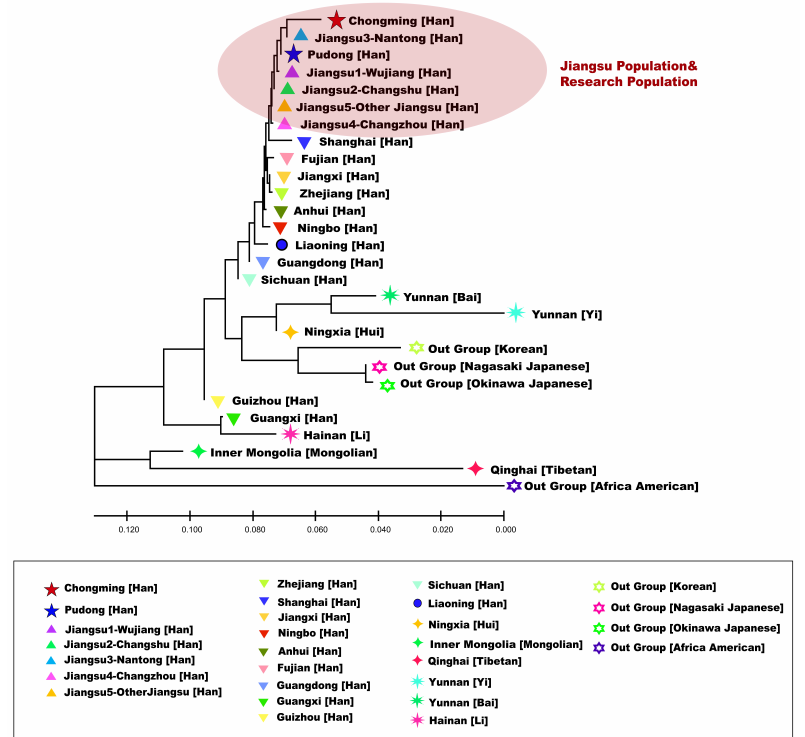
Figure 4. Phylogenetic tree of 28 populations constructed using the neighbor-joining method. Five populations of Han nationality in Jiangsu Province and the studied population are shown in the red circle. The illustrations correspond to those shown in Figures 1 and